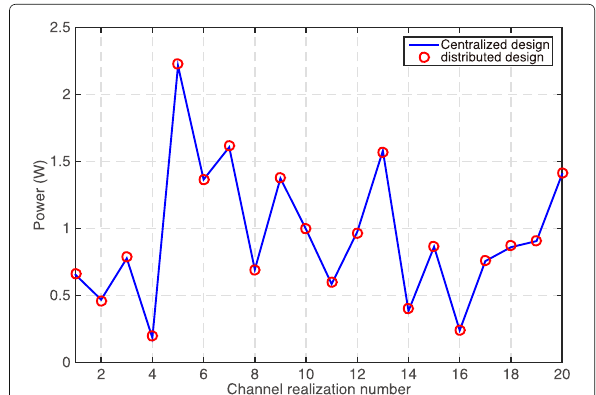
optimizing the transmit beamforming vectors and the AN covariance matrixes at all transmitters, while guar- anteeing IRs and ERs’ QoS and avoiding the information intercepted by any Eve. Since the problem is non-convex, we solved it by applying SDR and proved that our pro- posed solution method guarantees the global optimal solution with full CSI in a centralized manner. We fur- ther presented a distributed AN-aided MCBF design using ADMM, with which, each transmitter is able to calculate its own beamforming vectors and AN covariance matrix based on its local CSI. Simulation results showed that our proposed distributed algorithm converges to the opti- mal results obtained by the centralized one. Some insights are derived as follows. For the same secure transmis- sion requirements, the proposed AN-aided MCBF con- sumes less power than the non AN-aided MCBF. With increment of transmit antennas, the total required power decreases and the effect of AN on the total required power decreases. Compared with the traditional linear EH model, employing the non-linear EH model avoids false output power at the ERs and save power at the transmitter.